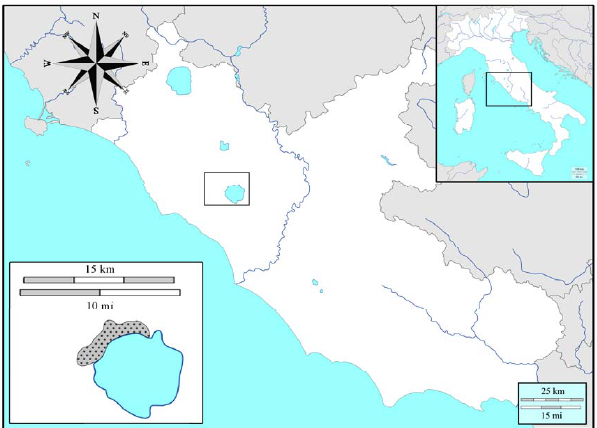
Figure 1. Map of the study area, depicting Italy (top right), the Lazio region and the sampling area on the hills north-west of Lake Bracciano (bottom left,